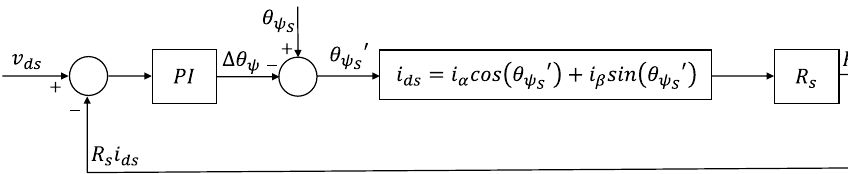
Figure 10. Stator flux angle compensation block diagram.